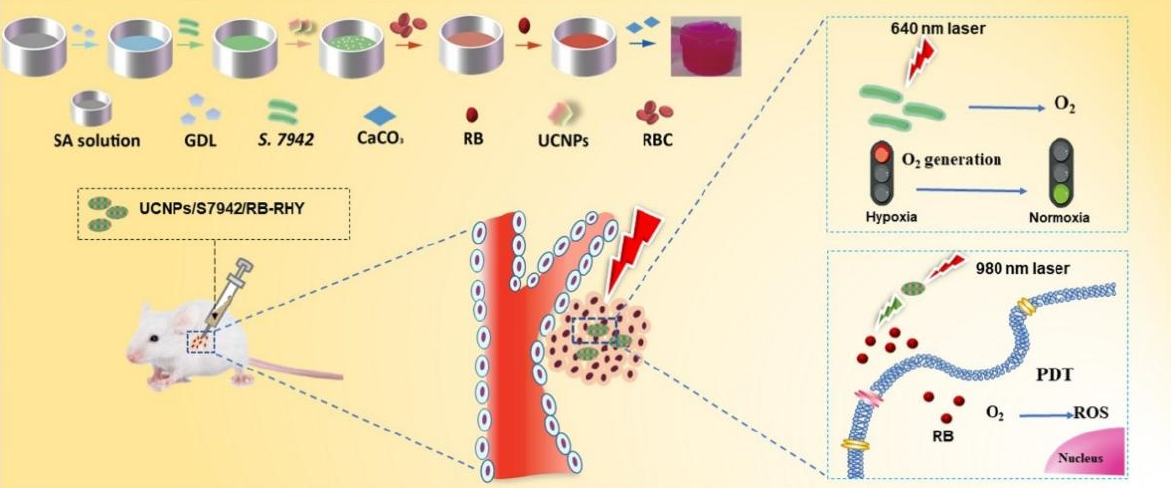
Figure 5. Schematic illustration of the preparation process of the novel anti-hypoxia hydrogel system for antitumor PDT. Reprinted with permission from [187].